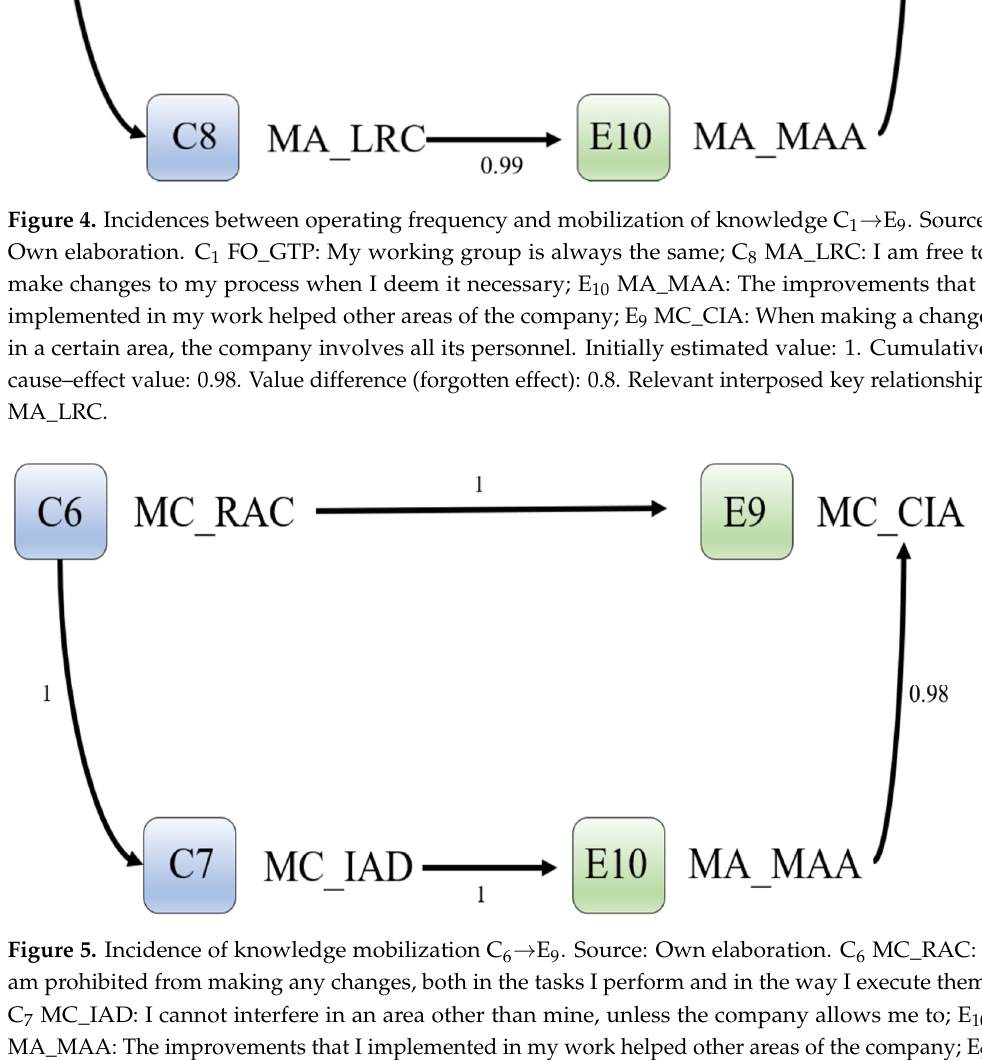
Figure 4. Incidences between operating frequency and mobilization of knowledge C 1 → E 9 . Source: